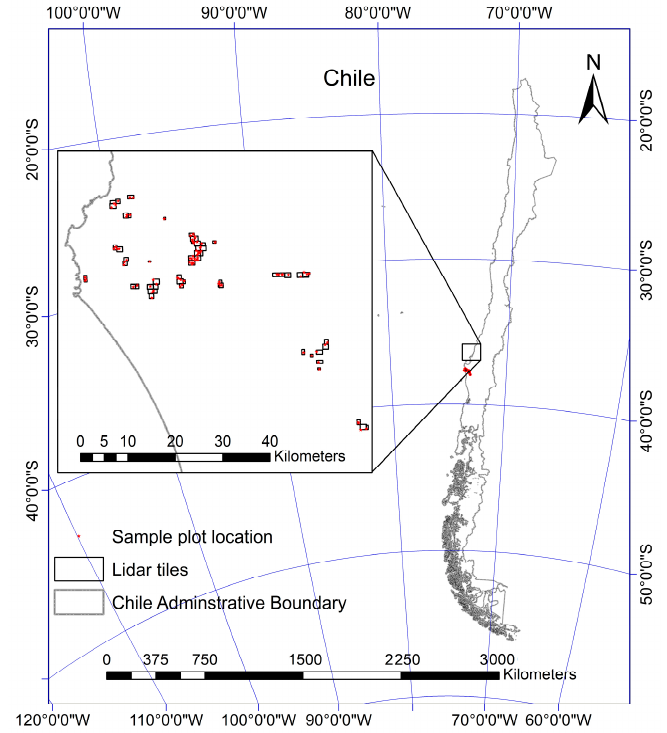
Figure 1. Study area and plots’ location in the Bio Bio region, central Chile.